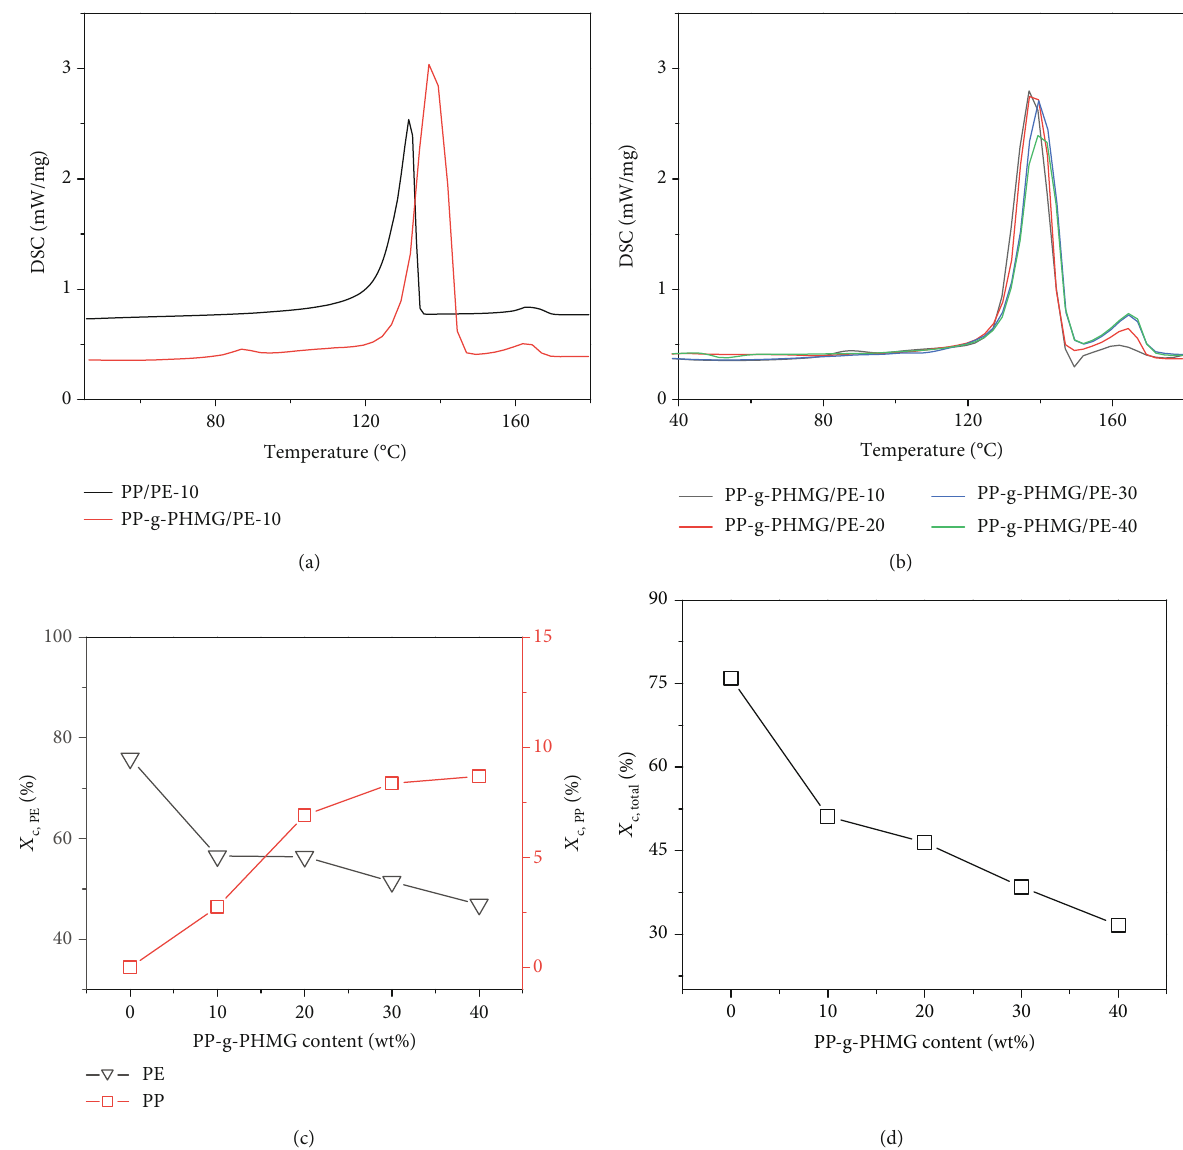
Figure 4: (a) DSC curves of PP/PE mono fi laments without grafting PHMG and PP-g-PHMG/PE alloy mono fi laments, (b) DSC curves of PP/PE mono fi laments with di ff erent PP-g-PHMG contents, (c) the dependence of crystallinity for PE and PP, and (d) the dependence of total crystallinity on PP-g-PHMG content. Table 1: Melting and crystallization behavior of PP-g-PHMG/PE alloy mono fi laments.